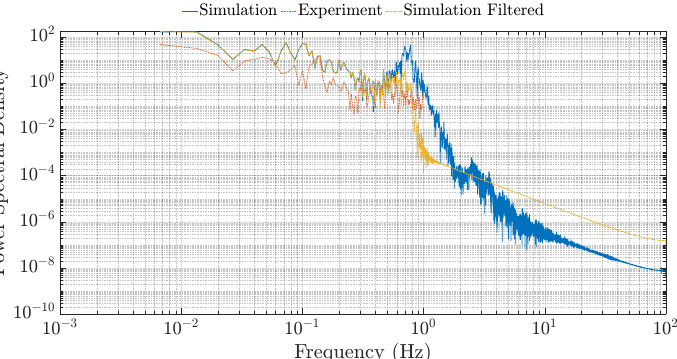
Figure 15. Power spectral density of the ground-station rotational speed for the multi-spring model with and without a low pass filter applied compared to the experimental data.